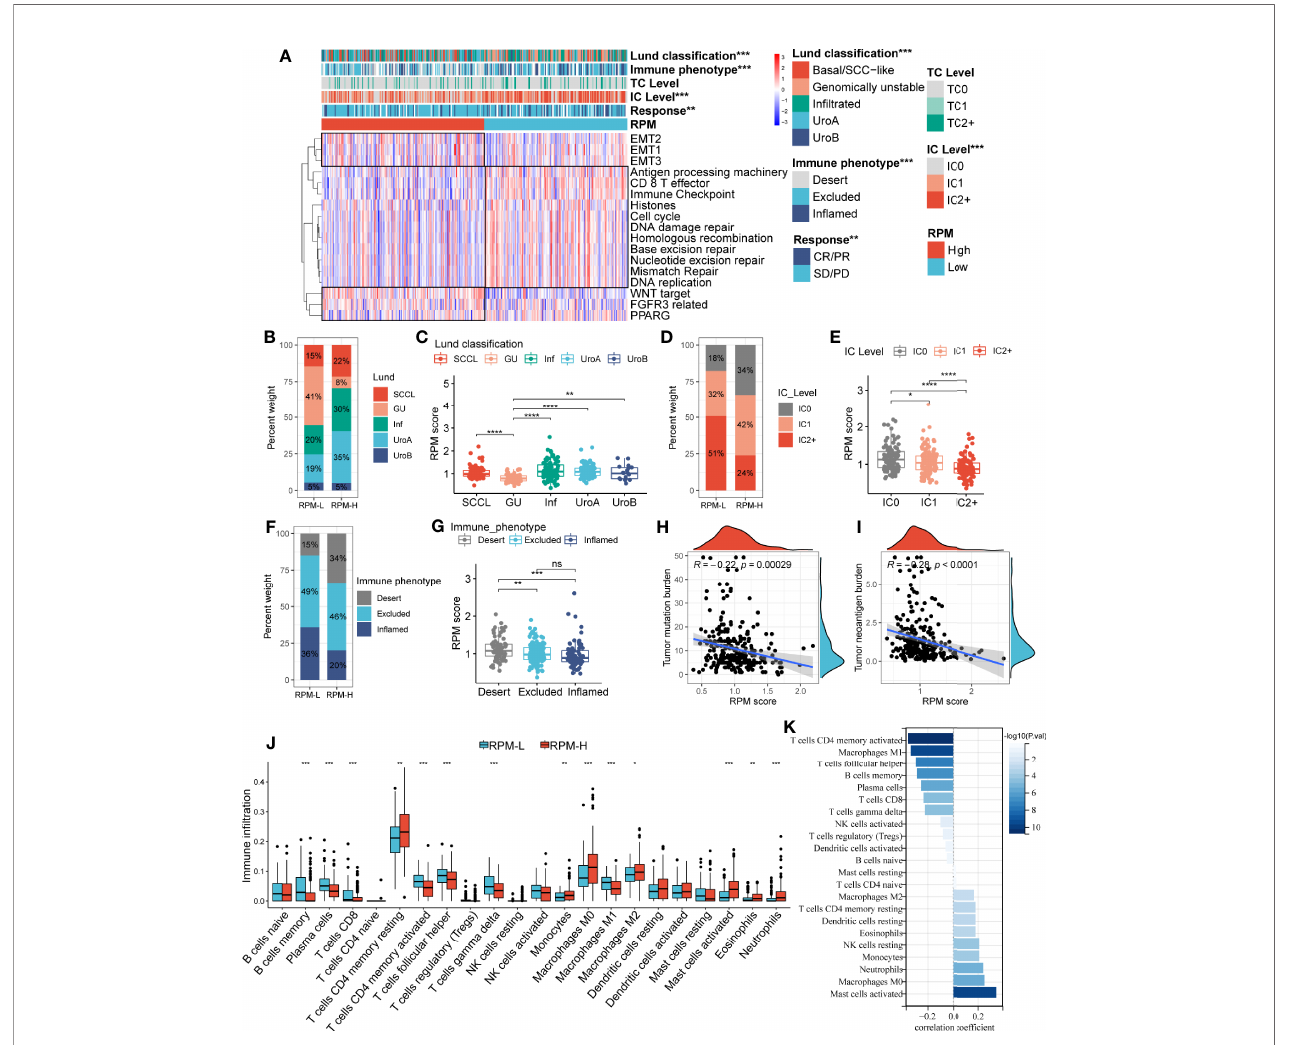
FIGURE 4 | Correlation of the RPM with clinical characteristics and immune cell in fi ltration. Panel A showed the correlation between IGSC subtypes and clinical and immune features. (B, D, F) The proportions of Lund classi fi cations, IC levels, and immune phenotypes in different RPM groups. (C, E, G) The RPM scores in different Lund classi fi cations, IC levels, and immune phenotypes. (H, I) Correlations of RPM scores with TMB and TNB. (J) Immune cell in fi ltration in RPM-L and RPM-H groups. (K) Correlation between RPM scores and density of in fi ltrating immune cell. * P < 0.05, ** P < 0.01, *** P < 0.001, **** P < 0.0001; NS, nonsigni fi cant; RPM, risk prediction model; IGSC, immunologic gene sets-based classi fi cation; IC, immune cells; TMB, tumor mutation burden; TNB, tumor neoantigen